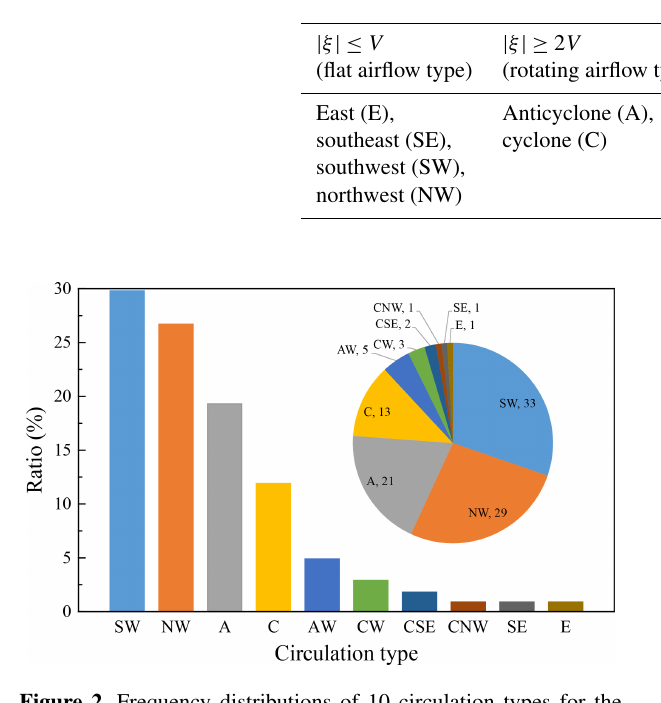
Table 1. Lamb–Jenkinson circulation types.